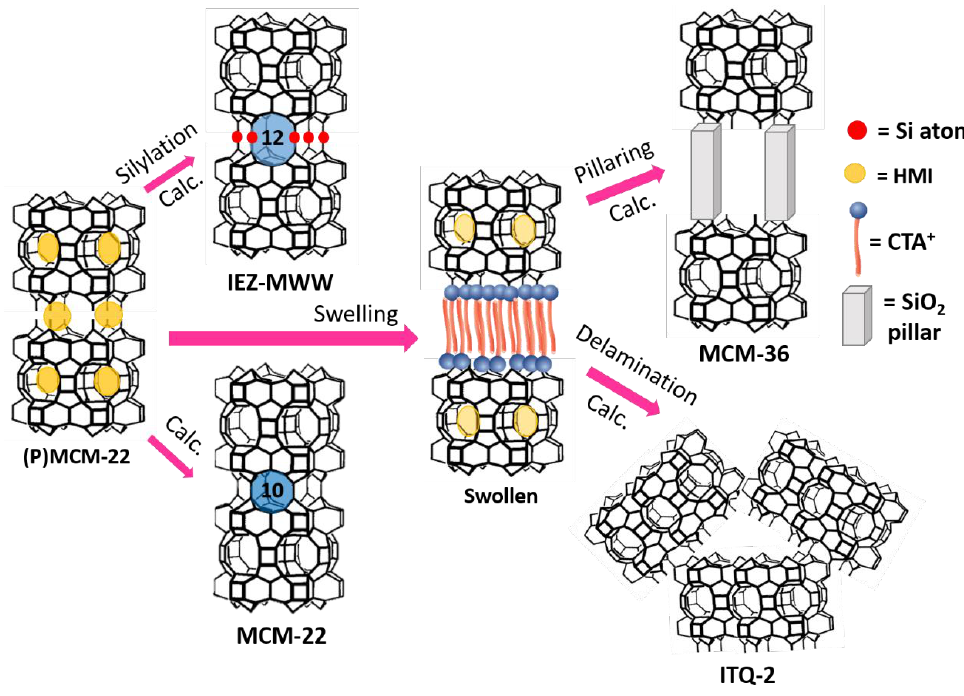
Figure 4. Representation of the postsynthetic procedures to obtain the interlayer expanded zeolite IEZ-MWW, swollen, pillared (MCM-36), and delaminated (ITQ-2) MWW-type materials.